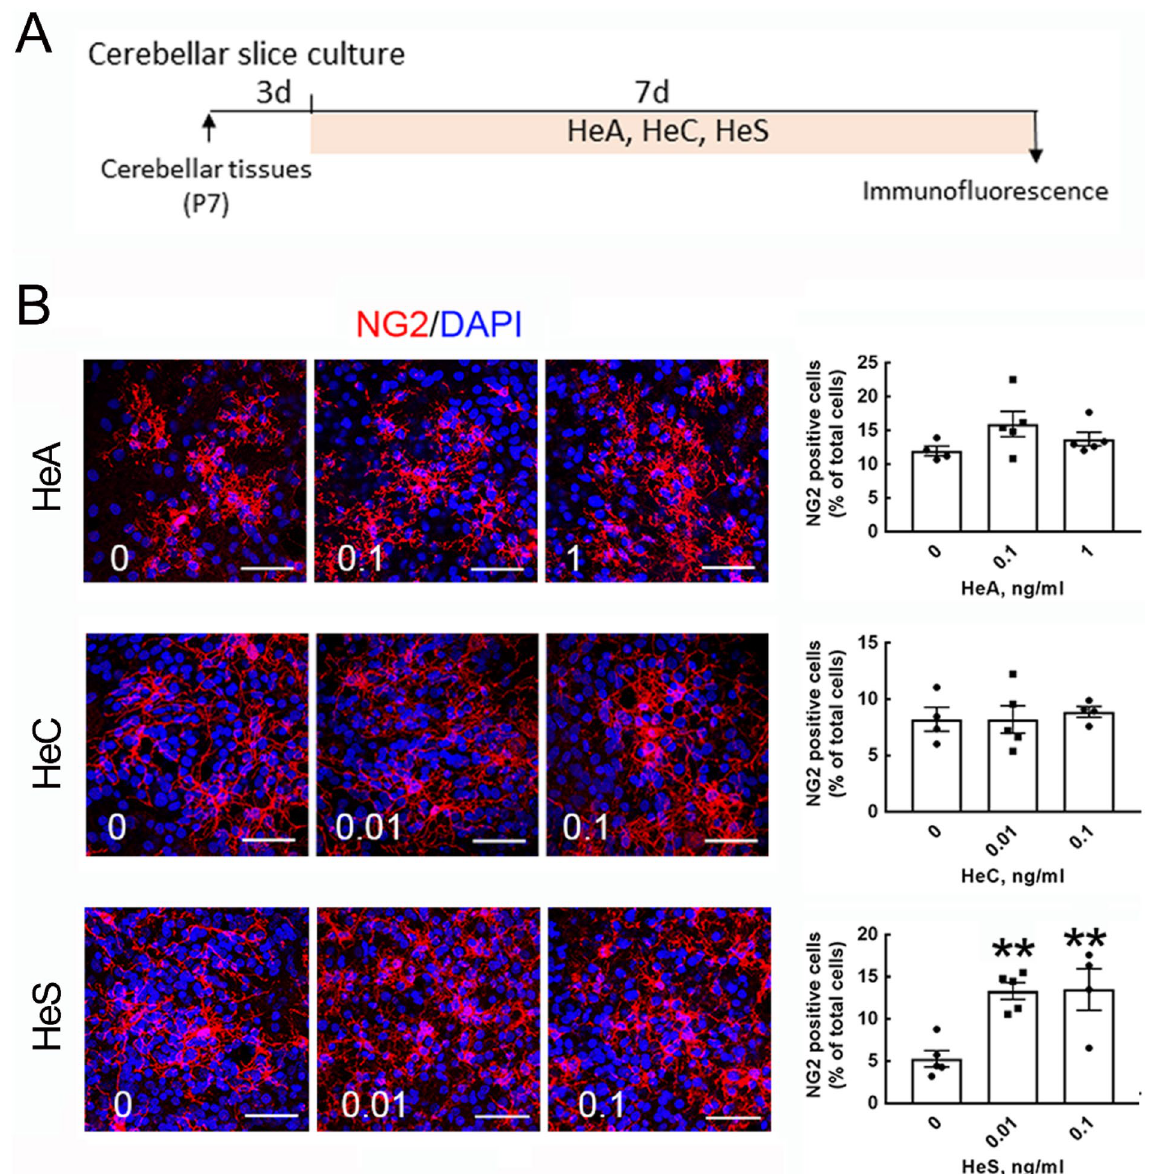
Figure 6. Exposure to HeS increased the number of NG2 + -OPCs in cerebellar tissue slices. ( A ) The schematic diagram depicts that HeA, HeC, and HeS at the indicated concentrations were added to cerebellar slice cultures and incubated for 7 days. ( B ) The cultures were subjected to NG2 immunofluorescence (red) and DAPI nuclear counterstaining (blue). The representative images captured from confocal microscopy (left panel) and NG2 + - OPCs in 4 random fields per culture were quantified as described in “Materials and methods” section (right panel). The results are presented as the means ± SEMs of the total tissue slices (n = 4–5) for each treatment. Each dot denotes data obtained from one tissue slice. ** p < 0.01 compared with the corresponding control culture. Scale bar, 50 with the culture system, whereas HEM was dissolved in soybean oil for the in vivo experiment. The chemical structures of HeA, HeC, and HeS are shown in Fig. 1A. Animals. Pregnant Sprague–Dawley (SD) rats (approximately 400 ± 20 g per animal; n = 6; RRID: RGD_728193) and male SD rat pups at postnatal day 3 (P3; n = 12) or P7 (n = 6) were purchased from BioLASCO Taiwan Co., Ltd. To prepare primary cell cultures, the animals were sacrificed by an intraperitoneal (i.p.) injec- tion of Zoletil 50 (Virbac Taiwan Co., Ltd.; 0.1 ml/100 g for rats) before the embryos were removed. The choice of anesthetics and the method of anesthesia were carried out in compliance with the ARRIVE guidelines. Given that MBP expressing in OLs can be detected initially at P3 in the corpus callosum at P3 following myelinated axons seen in P10 8 , rat pups (n = 6) at P3 received the daily oral administration of crude HEM (0.1 and 1.0 mg/kg) for 7 days. Since the crude HEM used for the animal experiments was dissolved in soybean oil,